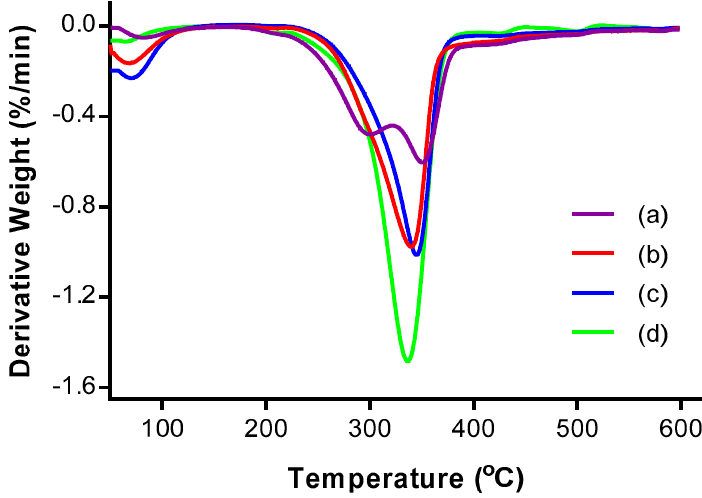
Figure 5. Derivative thermogravimetric (DTG) thermograms of (a) OPMF, (b) alkaline treated OPMF, (c) bleached OPMF and (d) CNC.